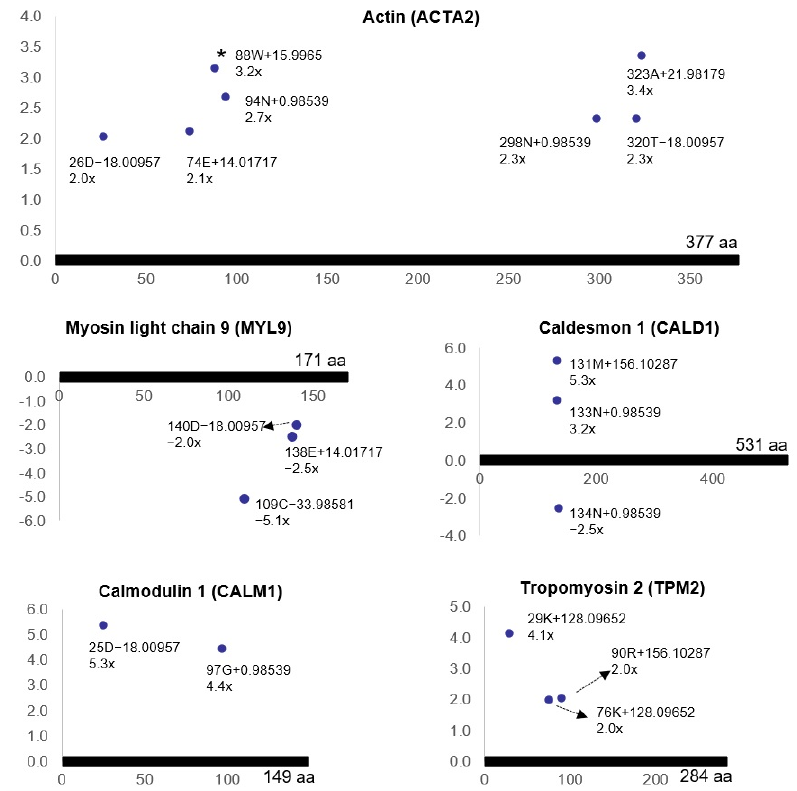
Figure 9. Post-translational modifications of contractile proteins (R 2 > 0.5, ratio > 2, p < 0.05) in bladder ischemia. Dots represent non-coded amino acids (ncAAs) of each contractile protein. The annotation information of each dot is as follows: modified (protein) position, modified amino acid residue, delta mass, and ratio of modification. The horizontal axis represents the amino acid position of each protein; the vertical axis represents the ratio of modification (up or down). The asterisk denotes the oxidation of actin. This figure is taken from our previous publication [68].